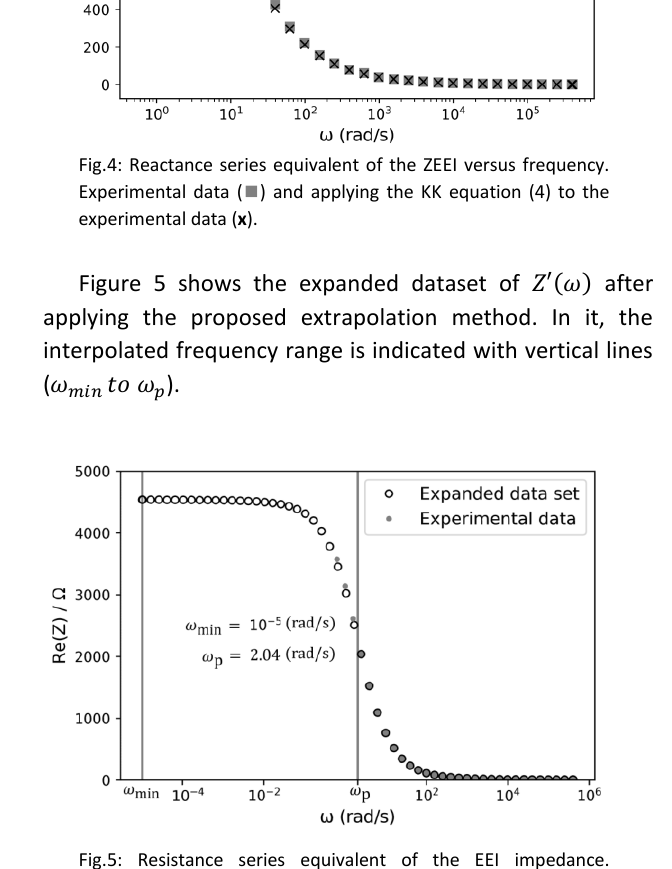
Fig.5: Resistance series equivalent of the EEI impedance. Expanded dataset (ο) and Experimental data (∙).